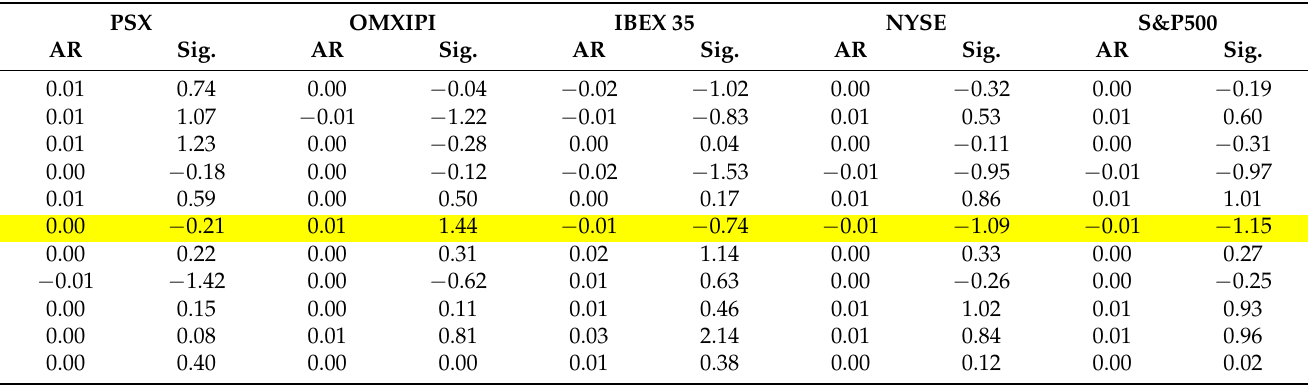
Table A23. Abnormal returns of the ( − 5, +5) event window for Leak of Panama papers (Jurgen Mossack Resignation).